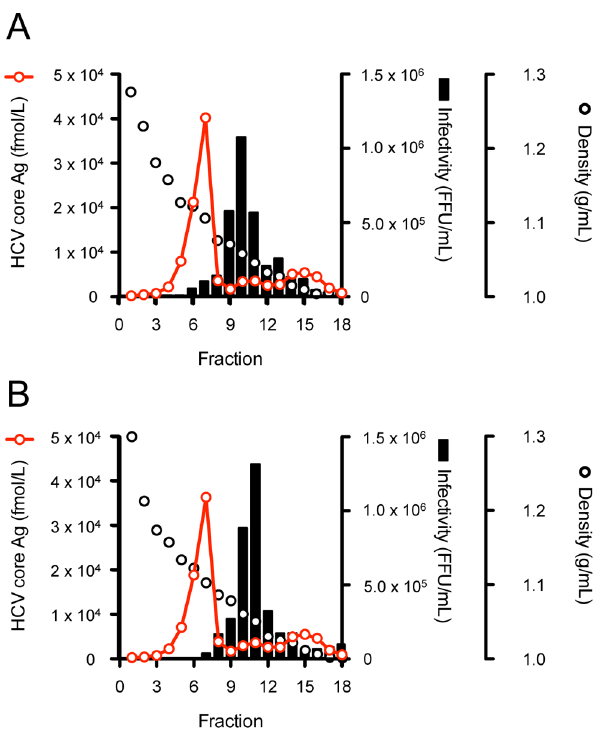
Figure 9. Iodixanol density gradient analysis of JFH-1/2G and JFH-1/6B. Huh7.5.1 cells were transfected with full-length RNAs of JFH- 1/2G and JFH-1/6B. Culture medium of each strain was collected and analyzed by 10%–40% of iodixinol density gradient. Fractions were collected, and HCV core Ag and infectivity titers of JFH-1/2G (A) and JFH-1/6B (B) were measured.